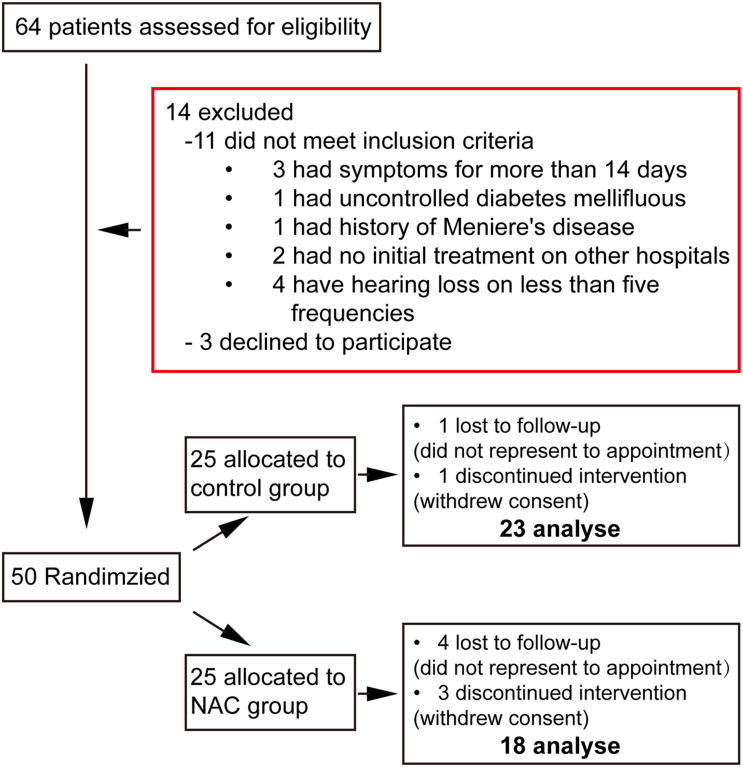
Study flowchart.